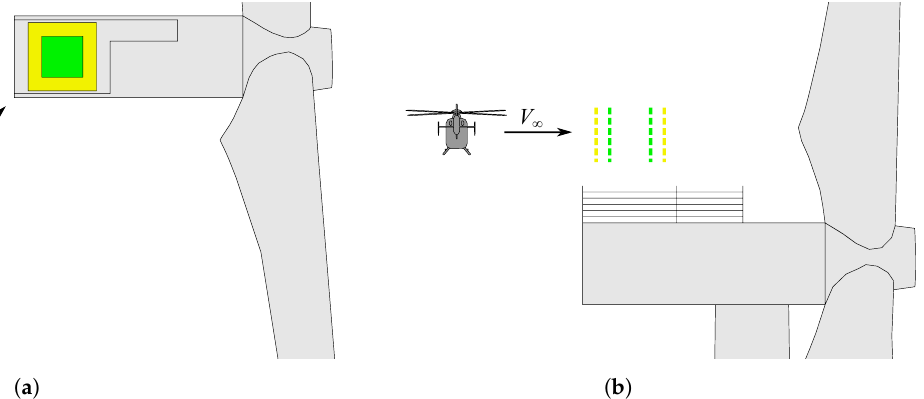
Figure 14. Hover task with performance limits at a non-rotating WT (OS-2). ( a ) Hover task at a non-rotating WT (top view); ( b ) Hover task at a non-rotating WT (side